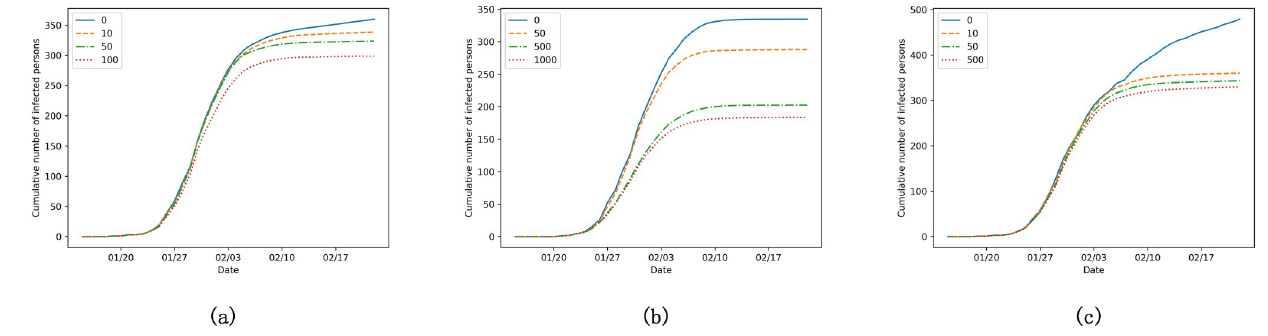
Fig 5. The sensitivity analysis of (a) w